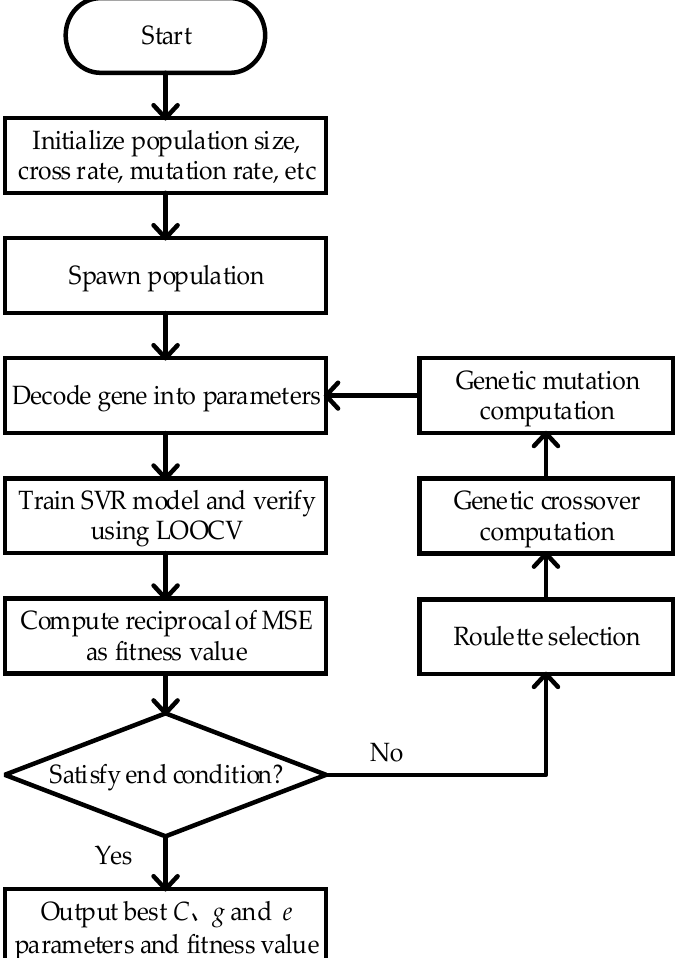
Figure 3. Flowchart of GA-SVR.